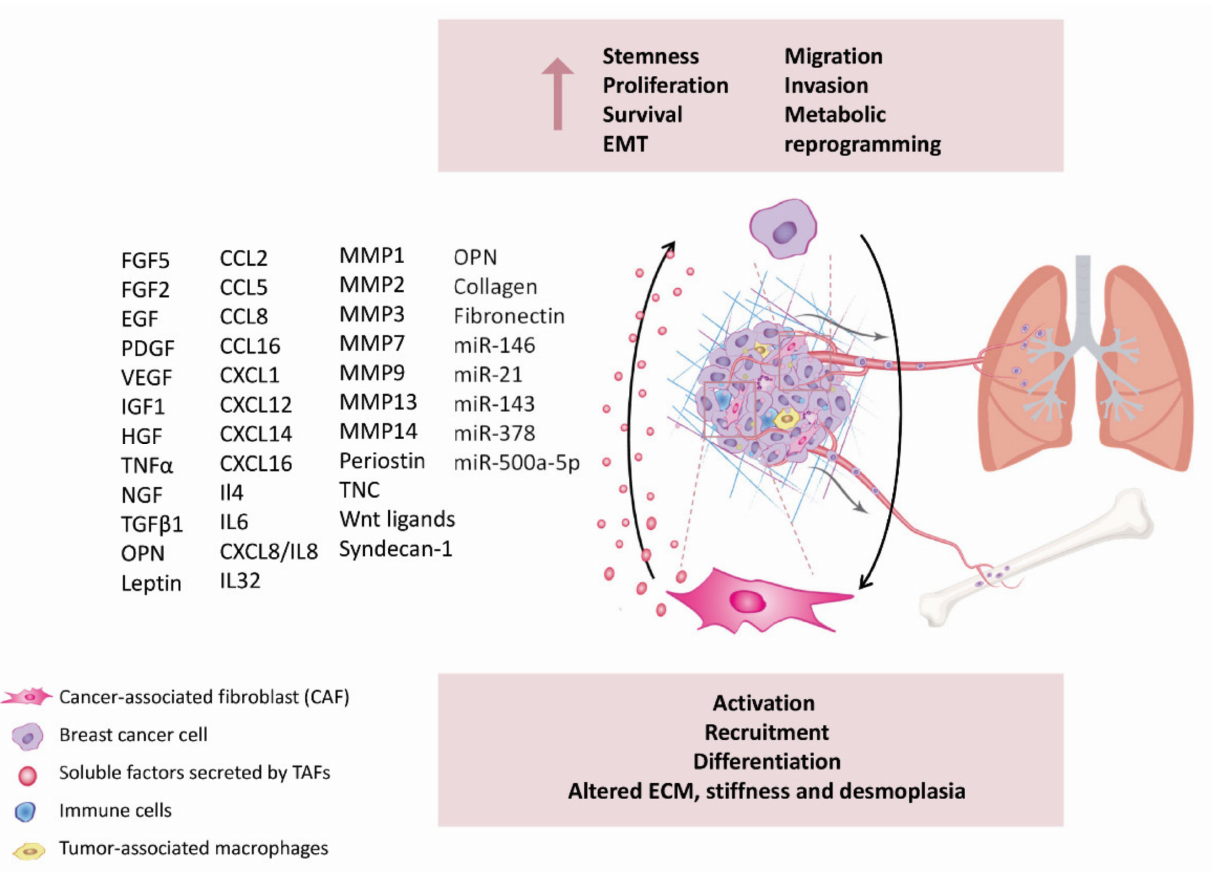
Figure 2. Pro-metastatic CAFs-secreted factors at the primary tumor promote tumor cell migration, invasion, and dissemi- nation. For a list of all proteins names abbreviations please see Table